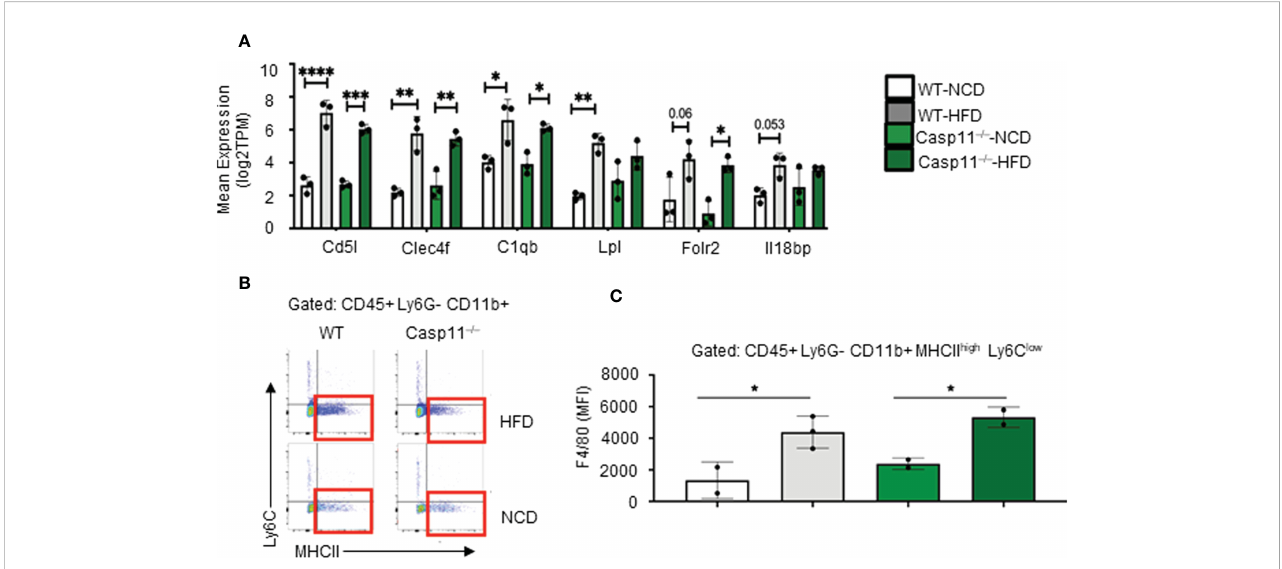
FIGURE 3 High-fat diet (HFD)-induced non-alcoholic fatty liver disease (NAFLD) drives the increase of NASH-related F4/80+ hepatic macrophages (HM F s) in WT mice, which are caspase-11 activation-independent. 8-10 weeks old male WT and Casp11 – / – mice were fed HFD for 12 weeks. (A) Bulk RNA-seq expression (TPM) of NASH-associated activated HM F genes. (B) Representative fl ow cytometry gating of HM F . Gated on CD45+ > CD11b+ Ly6G- > Ly6Clow MHCIIhigh. (C) F4/80+ mean fl uorescence intensity (MFI) for HM F populations. Statistical Analysis: Bulk RNAseq analysis was performed using Qlucore Omics Explorer. PCA generated using signi fi cantly differentially regulated genes (p.adj < 0.01). Included genes were signi fi cant (p < 0.05) in multi-variant analysis (Two-Way ANOVA). Marked signi fi cance (*) determined by One-Way ANOVA. *p < 0.05, **p < 0.001, ***p < 0.0001 ****p < 0.0001. Flow cytometry data was analyzed with FlowJo, and statistical analysis was performed using Prism. One-Way